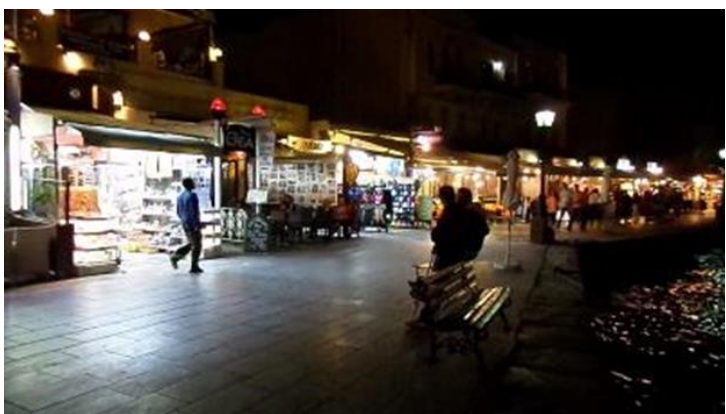
Figure 2. Typical evening in Old Port of Chania, Island of Crete: the sound environment is mainly determined by touristic activities as shopping, the promenade on the seaside, eating, drinking, and clubbing.